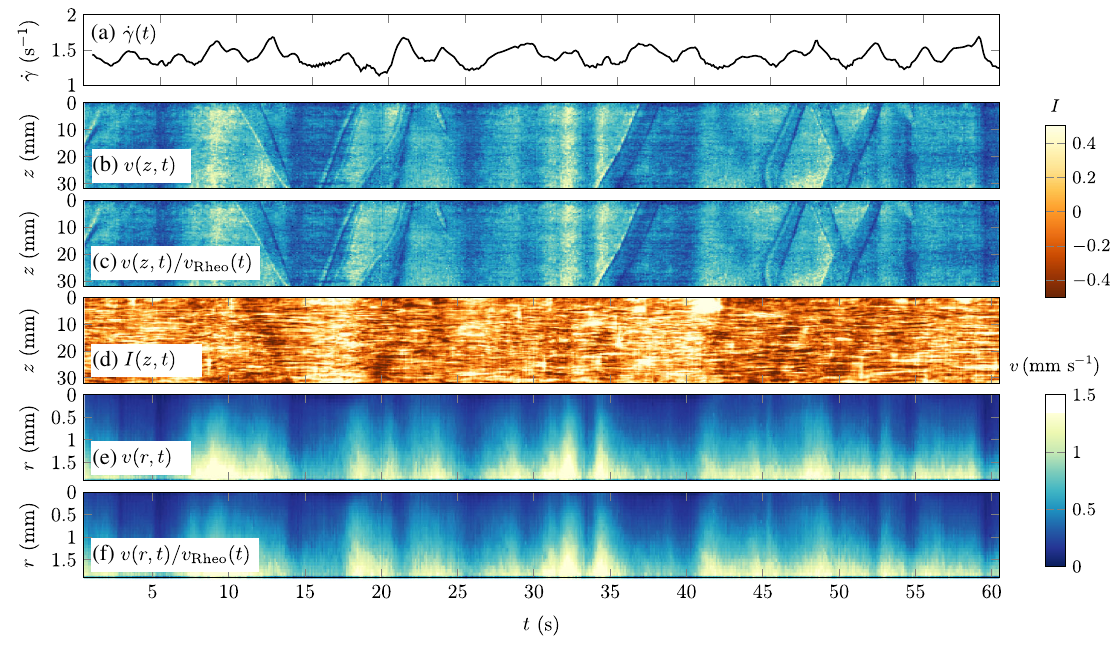
FIG. 15. Same as Fig. 13 in regime II for σ ¼ 80 Pa. See also Video 2.